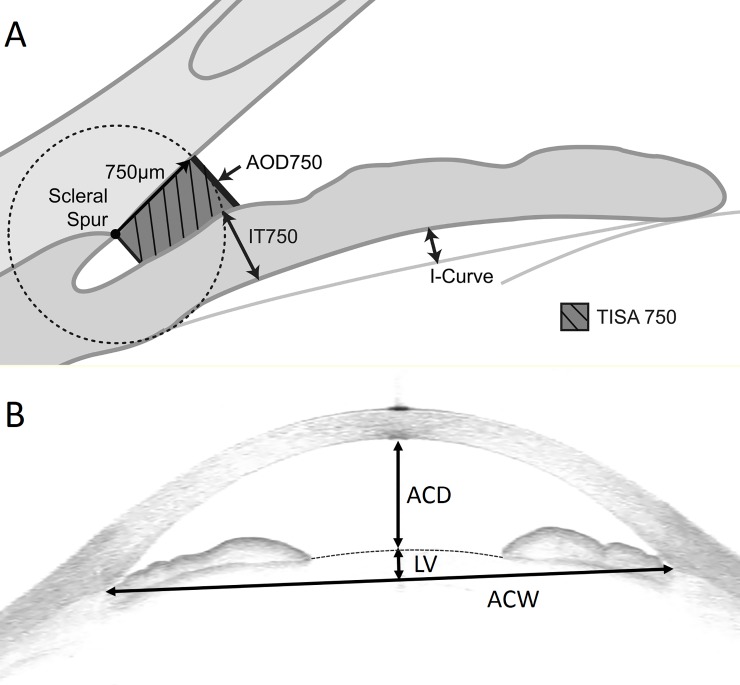
A and B. ASOCT image showing angle opening distance and trabecular iris surface area at 750 microns from the scleral spur (AOD750, TISA750), iris thickness (IT750), iris curvature (I-Curve), anterior chamber depth (ACD), anterior chamber width (ACW), and lens vault (LV).